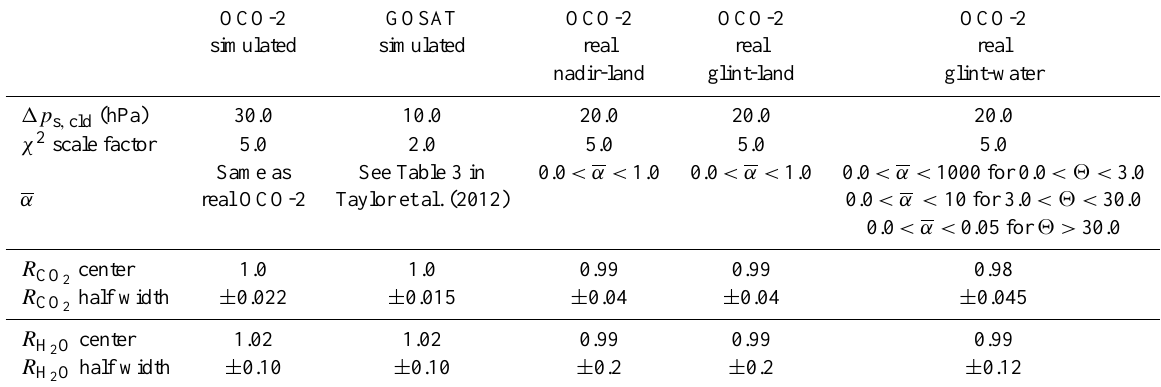
Table 1. Settings of the ABP and IDP cloud screening thresholds used for the OCO-2 and GOSAT simulated data sets discussed in Sect. 2.3 and the real OCO-2 data used in Sect. 4.2. Here, (cid:50) represents the glint angle, as defined in the text. OCO-2 GOSAT OCO-2 OCO-2 OCO-2 simulated simulated real real real nadir-land glint-land glint-water (cid:49)p s , cld (hPa) 30.0 10.0 20.0 20.0